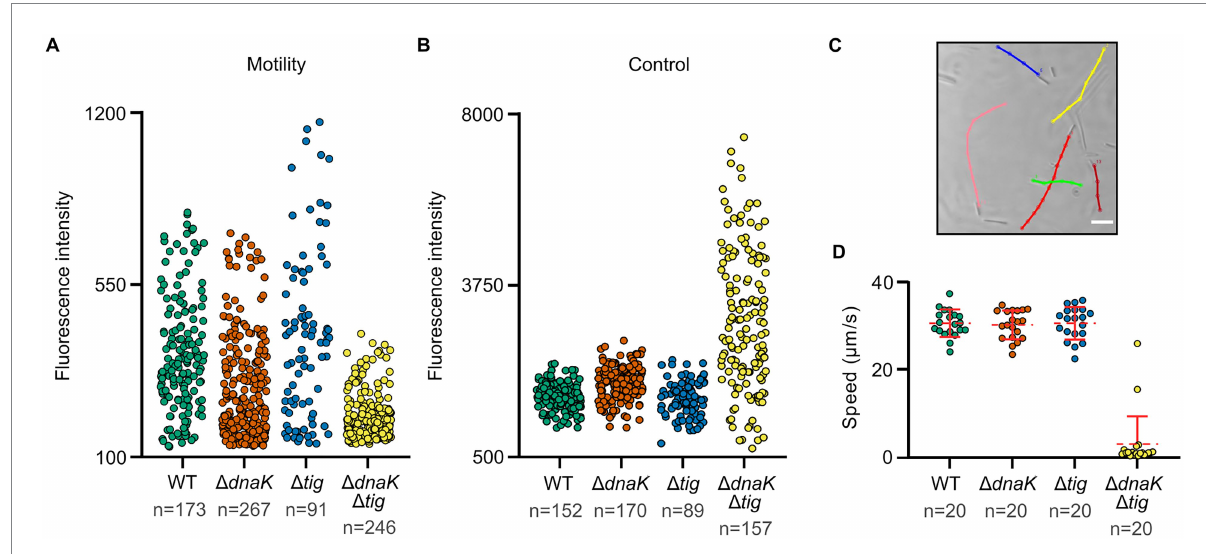
FIGURE 4 Motility of chaperone deletion mutants. (A,B) Fluorescence intensities of the four indicated strains expressing P hag -gfp and P const -gfp , respectively. Each dot represents the mean fluorescence intensity of a single cell. n denotes the number of cells analyzed for each strain. Mean intensities per cell were calculated by MicrobeJ (Ducret et al., 2016). Note that differences in motility gene expression between strains were assessed with the Mann–Whitney statistical test (two-tailed; significance level of 0.01). Pairwise comparisons were done, and the obtained p -values were corrected for multiple testing. Details can be found in Supplementary Data Sheet 1. Value of p < 0.01 were obtained for the following pairwise comparisons: wild-type and dnaK single mutant; wild-type and dnaK tig double mutant; dnaK single mutant and dnaK tig double mutant. (C) Representative example of B. subtilis wild-type (1A1) motility tracks. To study motility, microscopy videos were acquired for each strain, and individual cells were manually tracked using the MTrackJ plugin of Fiji (Schindelin et al., 2012). Cells for imaging were taken from NSMPG liquid cultures grown at 30 ° C until late exponential growth phase. Scale bars represent 10 μ m. (D) Filled dots show individual speed values of the different strains. n denotes the number of cells analyzed for each strain. Red horizontal lines represent the mean, and errors bars display the standard deviation between speed